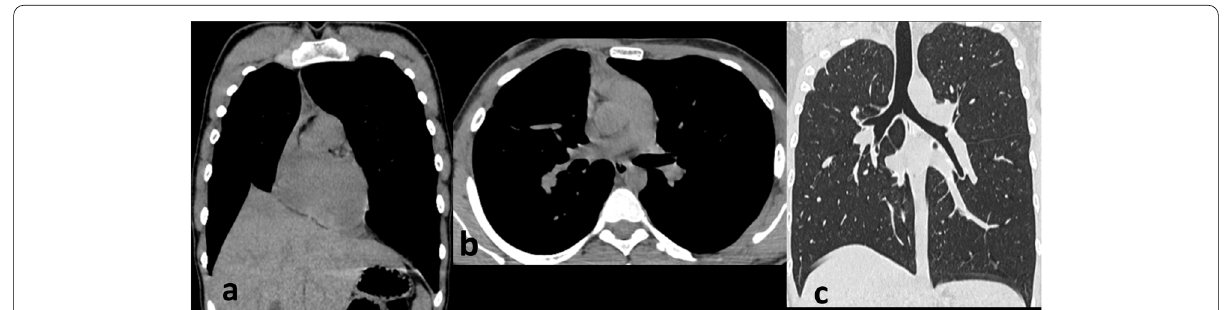
Fig. 2 Non-contrast computed tomography scan of the chest. a CT Coronal image in mediastinal window shows right side volume loss with ipsilateral mediastinal shift and elevation of the right hemidiaphragm. b CT Axial image in the mediastinal window shows the relatively small caliber right pulmonary artery ( c ) CT Coronal image in lung window shows complete absence of the right upper lobe pulmonary parenchyma, right upper lobe bronchi, and its vasculature. Also noted is the abnormal right oblique